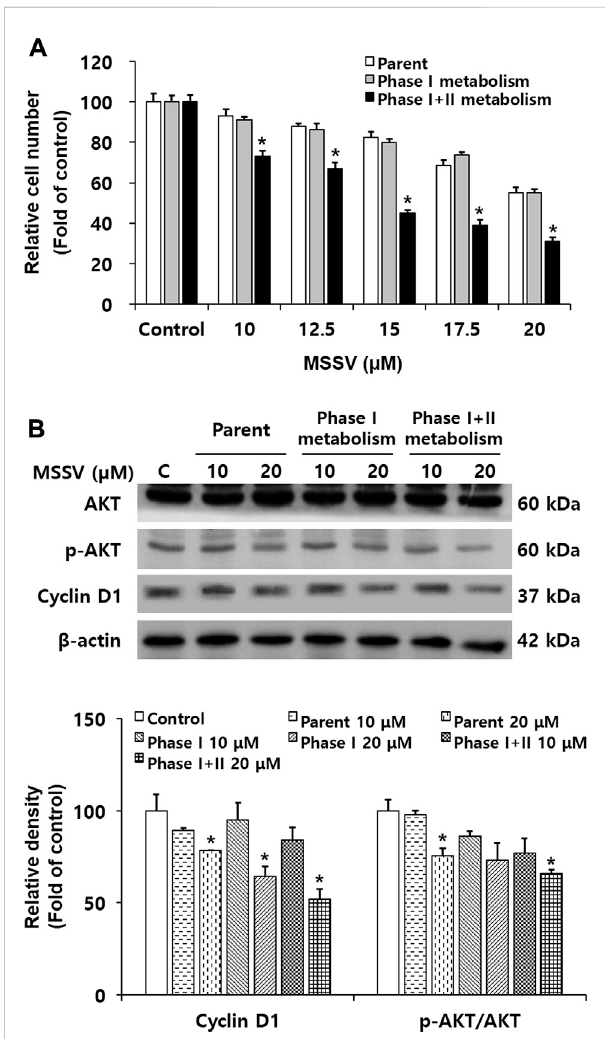
FIGURE 7 The anti-proliferative effects of MSSV were determined with treatment of S9 fractions against CRC cells (A) Cells were treated with various concentrations of MSSV and S9 fractions for 24 h. The trypan blue staining method was carried out for the cell counting assay. The bar represents the relative cell numbers at different concentrations of MSSV and statistically signi fi cant differences between the control and phase II metabolism group. (B) Western blotting was conducted to examine the sole and/or combination effect between MSSV and S9 fractions. Relative densities of cyclin D1 an p-AKT/AKT as a group are expressed as a bar graph. S9 fractions cause MSSV to more effectively inhibit the proliferation of HCT116 cells. Data are presented as mean ± SD and the * (asterisk) indicates a statistically signi fi cant difference. A p -value of < 0.05 was considered statistically signi fi